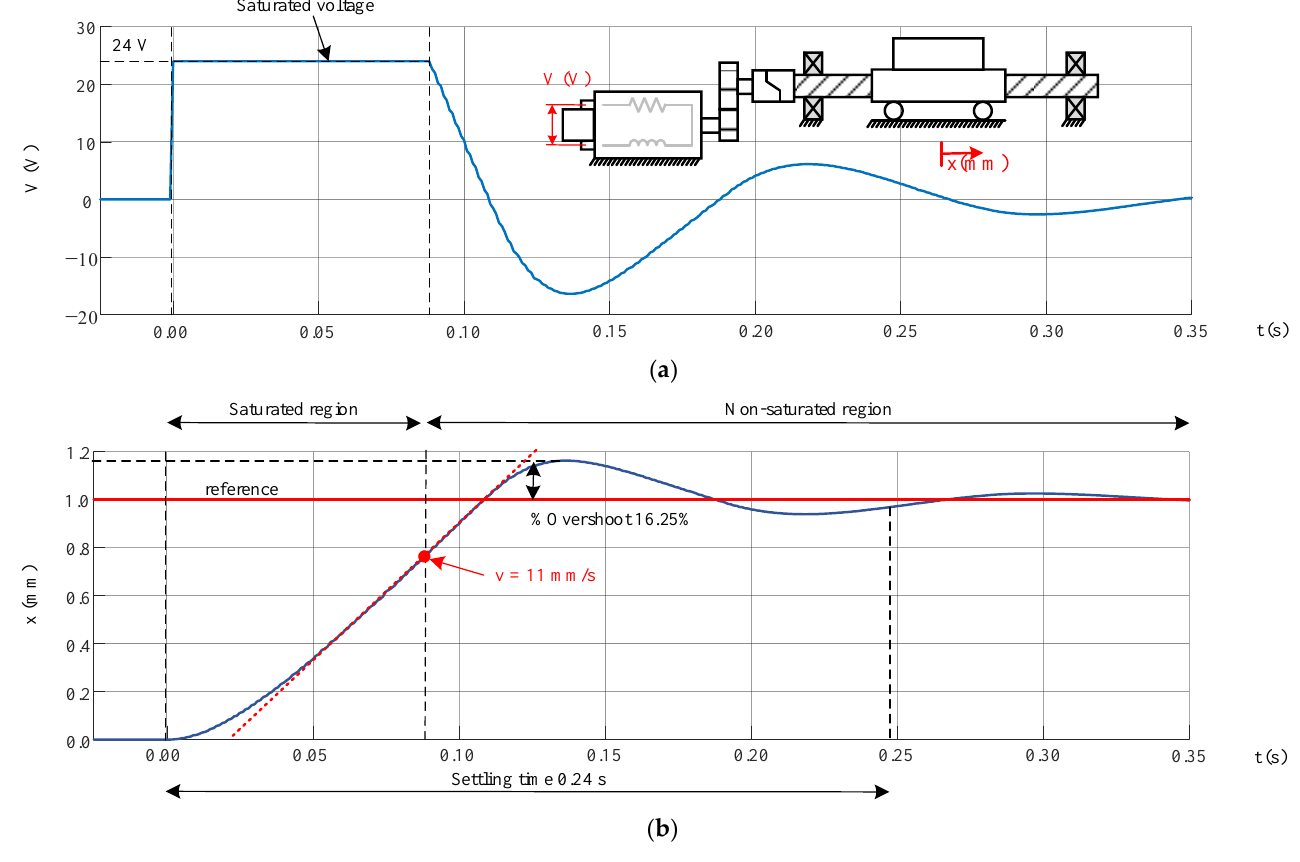
Figure 3. Closed − loop step responses: ( a ) Voltage input from the 24 V power supply, and ( b ) Carriage position corresponding to the input from the controller.